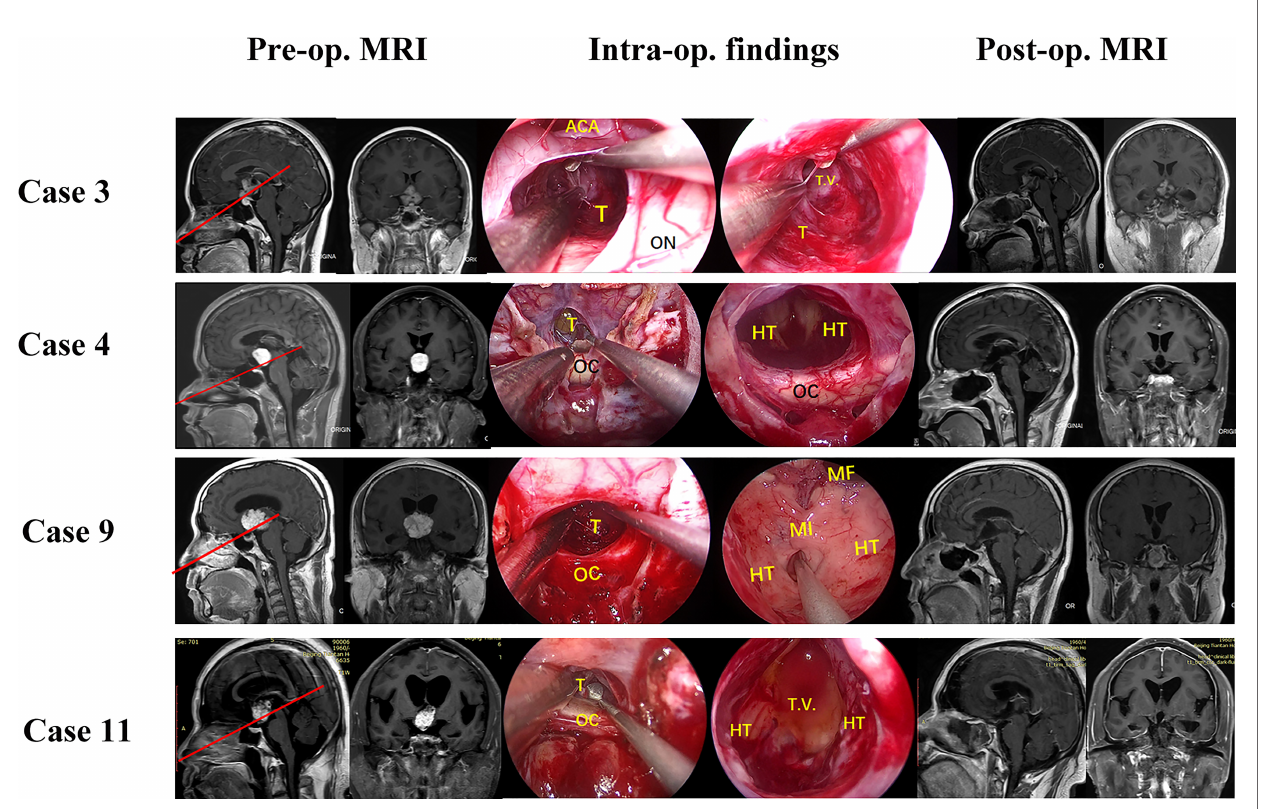
FIGURE 3 | Pre- and post-operative MRI and intraoperative fi ndings of 11 patients treat by combined trans-lamina terminalis and trans-pituitary-chiasm corridors. Case 3, a germinoma with supra-NCL part about 80% were partial resected via a TLTA and a radiotherapy and chemotherapy were followed. Case 4, a chordoid glioma with supra-NCL part about 95% were total removed by TLTA. Case 9, a papillary craniopharyngioma with supra-NCL part about 95% were removed totally by TLTA. Case 11, a papillary craniopharyngioma with supra-NCL part about 90% were removed totally by TLTA. OC, optic chiasm; PS, pituitary stalk; ON, optic nerve; T, tumor; P, pituitary; ICA, internal carotid artery; T.V., 3 rd ventricle; LT, lamina terminalis; HT, hypothalamus; MF, Monro ’ s foramen; TLTA,trans-lamina terminalis